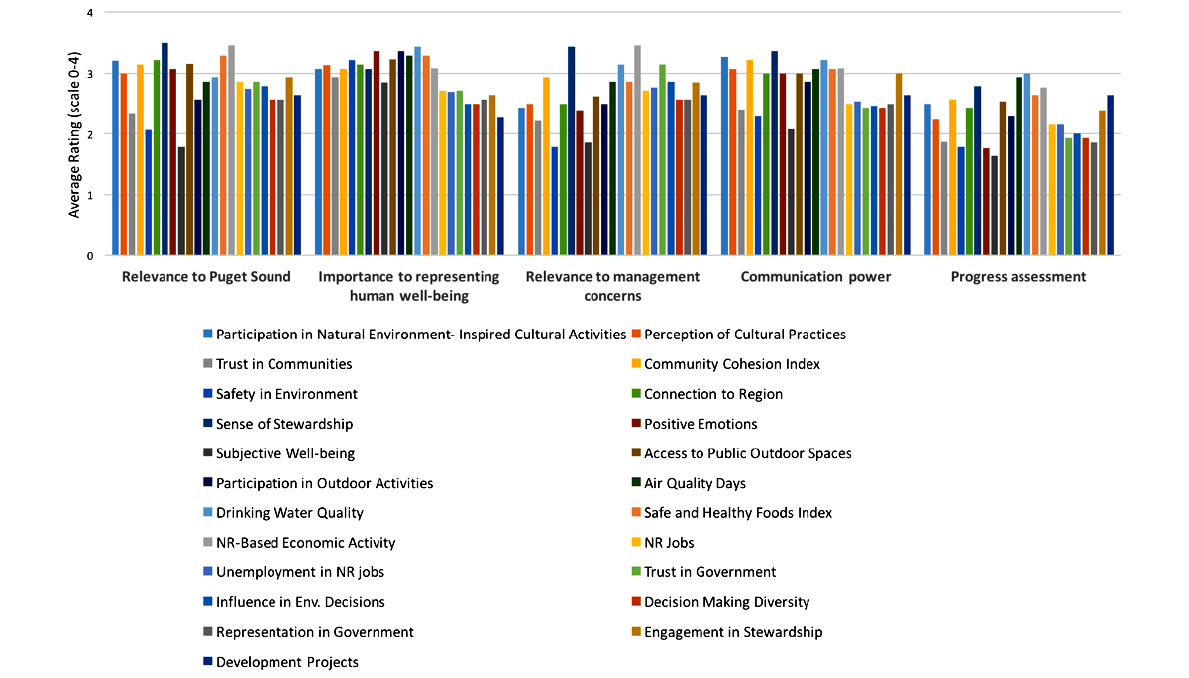
Fig. 3 . Average scores for the 23 indicators across the 5 criteria used by decision makers. NR, natural